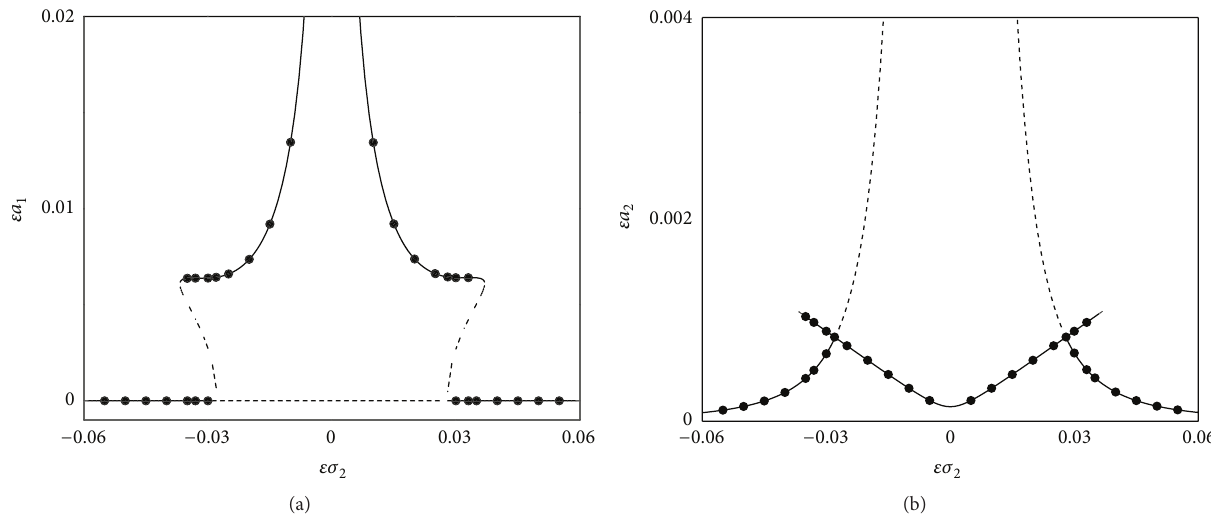
Figure 19: Comparisons in the second superharmonic resonance: (a) the first mode and (b) the second mode.